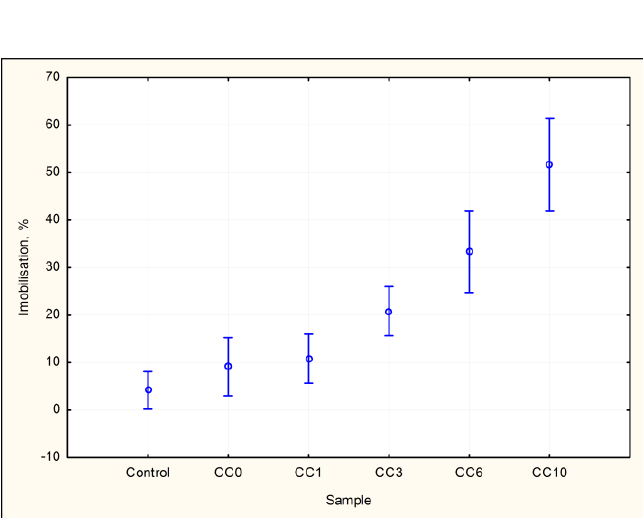
Figure 4. Graph 95% confidence intervals for imobilization by samples—acute toxicity test of Dafnia magna.